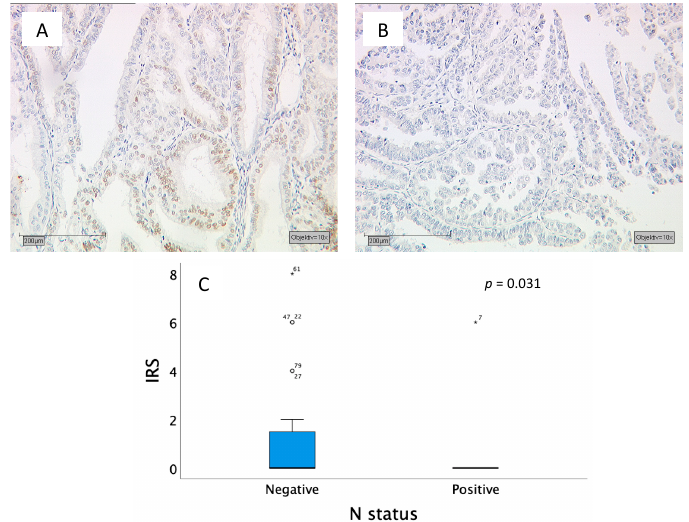
Figure 4. ( A ) and ( B ) Tumor samples stained for MSX1: ( A ) Tumor material of a patient with negative N status with an IRS of 2; ( B ) Tumor material of a patient with positive N status with an IRS of 0; ( C ) Boxplots with a median IRS of 0 for negative N status and with a median IRS of 0 for positive N status. The circle indicates values more than 1.5 box lengths from the 75th percentile. Asterisks indicate values which are more than 2times the box length. Numbers at circle and asterisks indicate sample